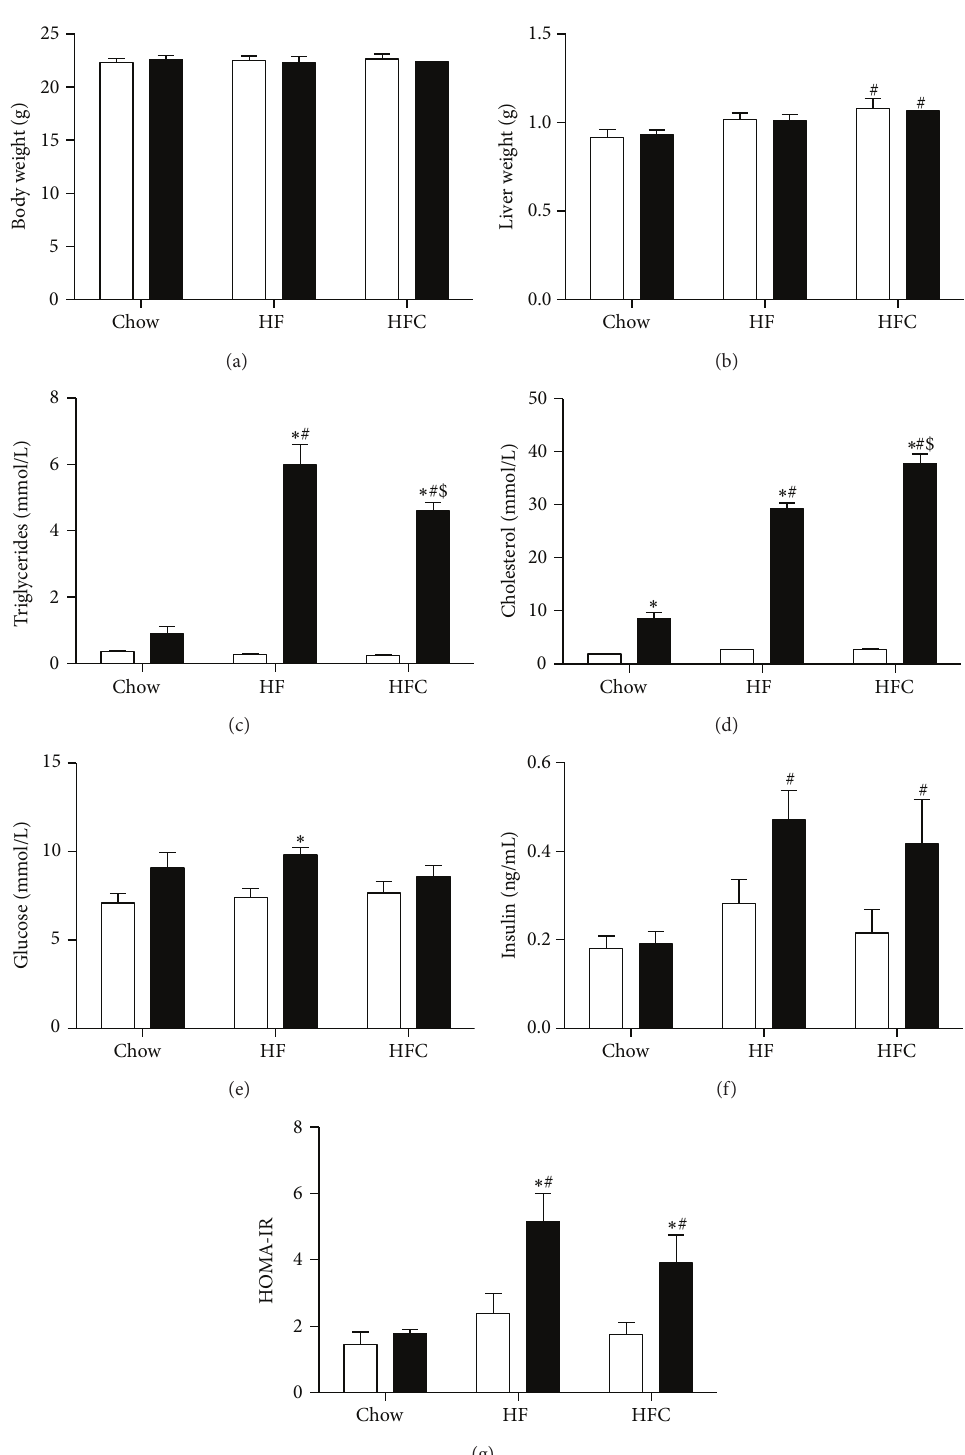
Figure 1: Circulating levels of lipids, glucose, and insulin in Ldlr −/− mice fed a chow, HF, or HFC diet for 2 weeks. Body weight (a) and liver weight (b) of WT and Ldlr −/− mice fed a chow, high-fat (HF), or high-fat cholesterol (HFC) diet were determined at time of sacrifice ( 𝑛 = 12 ). Plasma triglyceride (c), cholesterol (d), glucose (e), and insulin (f) levels were measured in blood obtained following a 6-hour fast ( 𝑛 = 5-6). (g) The homeostasis model assessment of insulin resistance (HOMA-IR) was calculated from fasted insulin and glucose levels ( 𝑛 = 6 ). Data are expressed as means ± SEM for WT mice (white bars) and Ldlr −/− mice (black bars). ∗ 𝑃 < 0.05 WT versus KO; # 𝑃 < 0.05 HF, HFC versus chow; $ 𝑃 < 0.05 HF versus